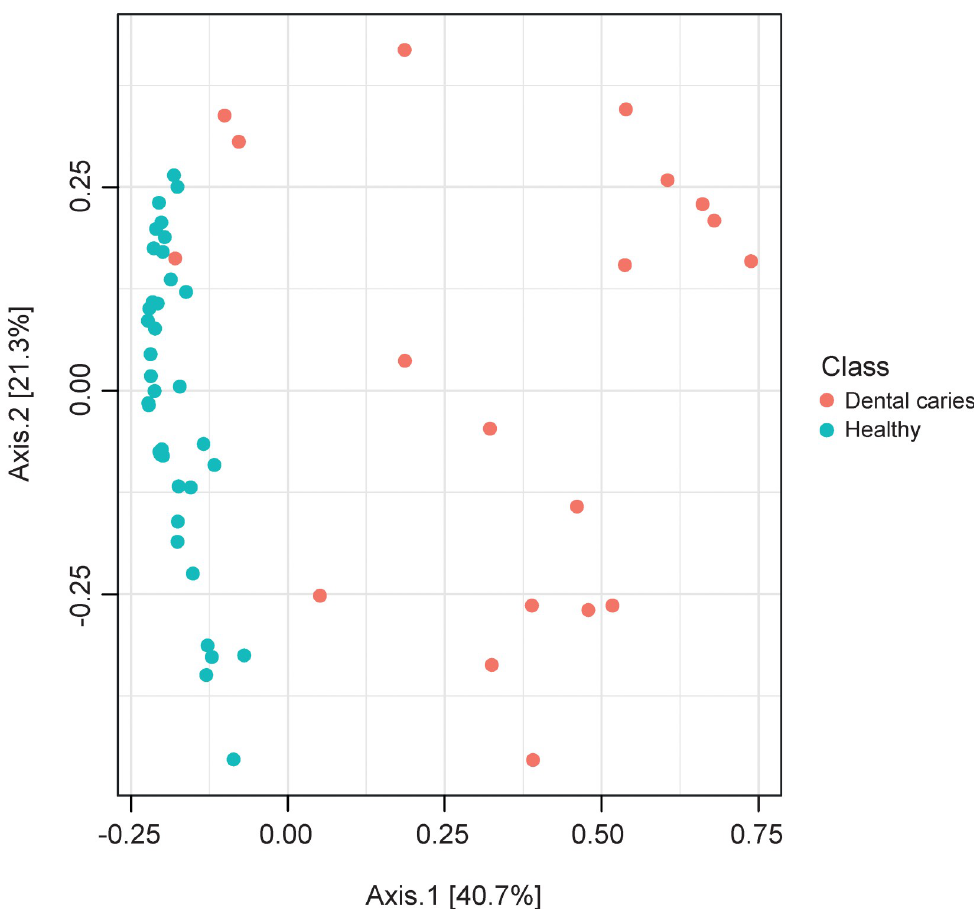
Fig 3. Similarity of microbiome composition. Scatter plot of the Principal Coordinates Analysis (PCoA) using the Morisita-Horn dissimilarity index.